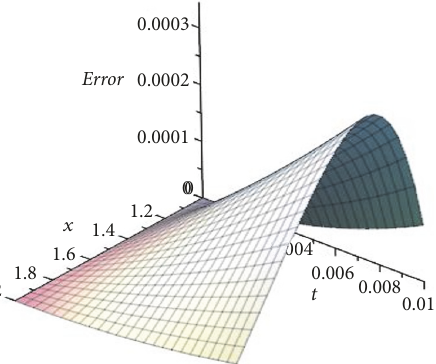
Figure 4: Absolute error for (28) using VIMB when n=m=8 and 𝑡 = 0.01 .